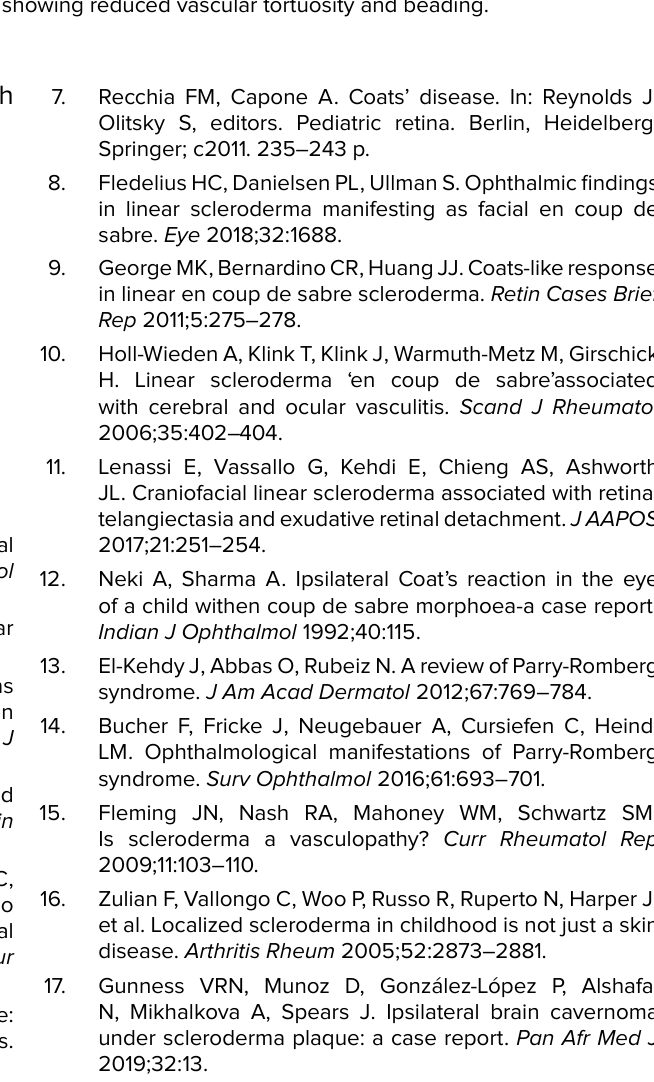
Figure 4. Fundus photograph at 12-month, showing reduced vascular tortuosity and